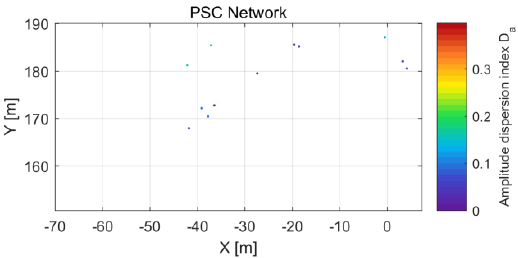
Figure 3. Result of selected PSC representative points.